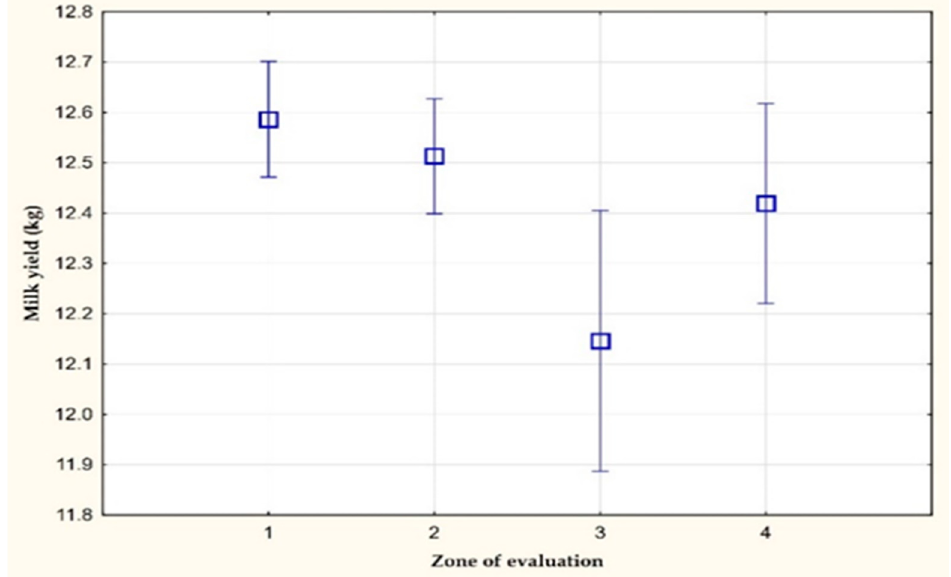
Figure 2. The amount of milk yield per milking (kg) on farm D.